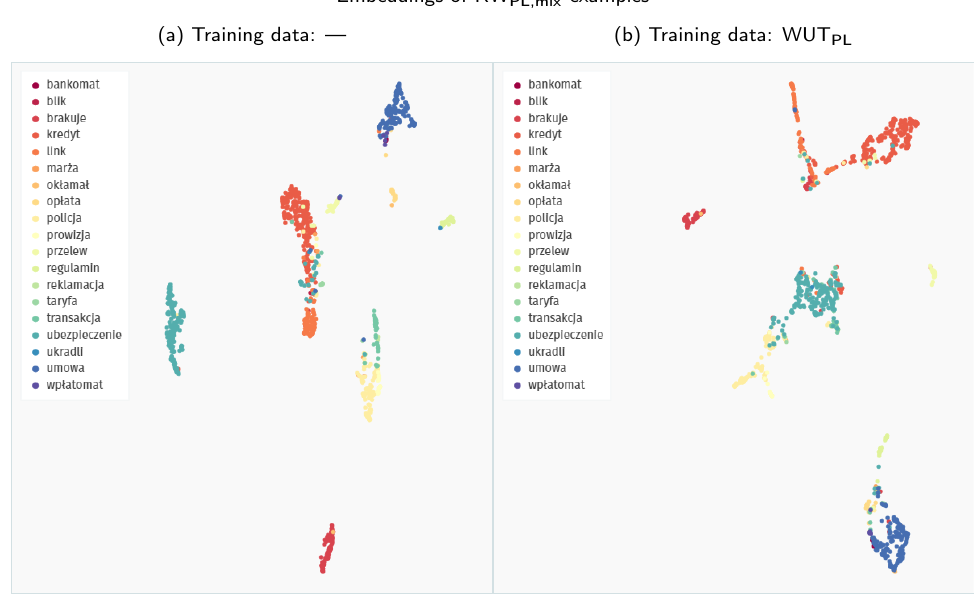
Figure 8. Comparison of the UMAP visualisations of Polish keywords processed through the Google speech embedder: ( a ) embeddings generated with a pre-trained model without fine-tuning; ( b ) embeddings generated with a pre-trained model fine-tuned on WUT PL training